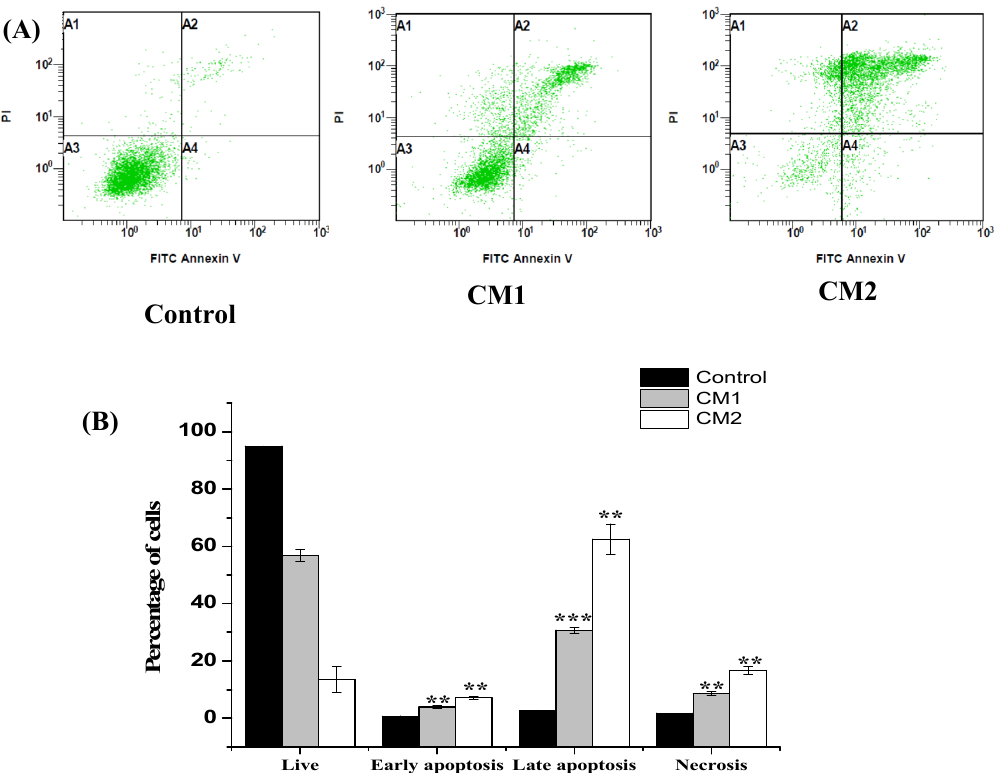
Figure 4. HepG2 cell death after treatment with compounds CM1 and CM2. Cells were exposed to the IC 50 for 48 h, and cells undergoing either apoptosis or necrosis were assessed using co-staining with Annexin-V/FITC-PI dyes. (A) Representative scatter plots of PI ( y -axis) vs. FITC-Annexin V ( x -axis); live cells (A3) were negative for both dyes, (A4) early apoptotic cells were positive for only FITC -Annexin V, (A2) late apoptotic cells were stained with both dyes and(A1) Necrotic cells were stained with PI only. (B) Percentage of viable, early apoptotic, and late apoptotic + necrotic cells. Data are presented as the means ± SD of the triplicate experiments. *P < 0.05 and **P < 0.01 vs. control.